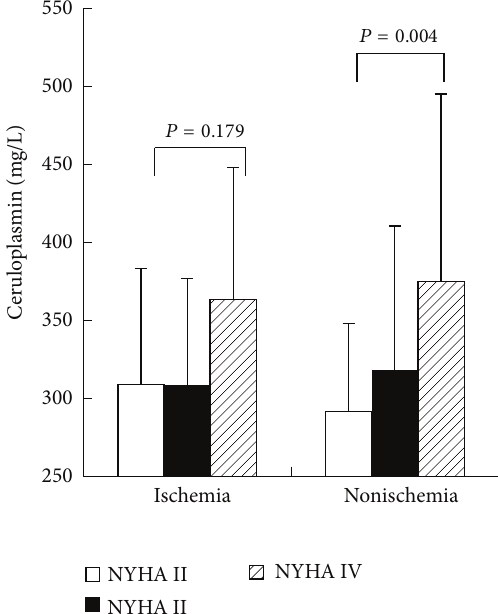
Figure 2: Ceruloplasmin levels in NYHA II, NYHA III, and NYHA IV subgroups. There was no significant difference among different NYHA subgroups in ischemic cardiomyopathy patients (𝑃 > 0.05) . In nonischemic cardiomyopathy patients, the CP levels showed statistical difference among NYHA II, NYHA III, and NYHA IV subgroups (𝑃 < 0.05)